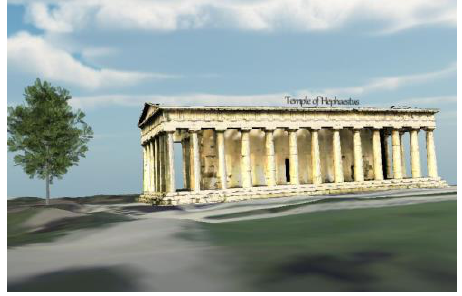
Figure 15: A screenshot of the virtual tour